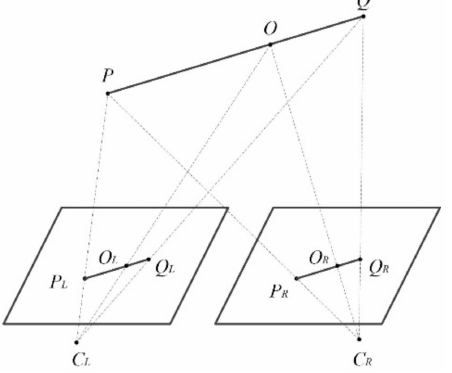
Figure 4. Schematic diagram of affine distance transformation.